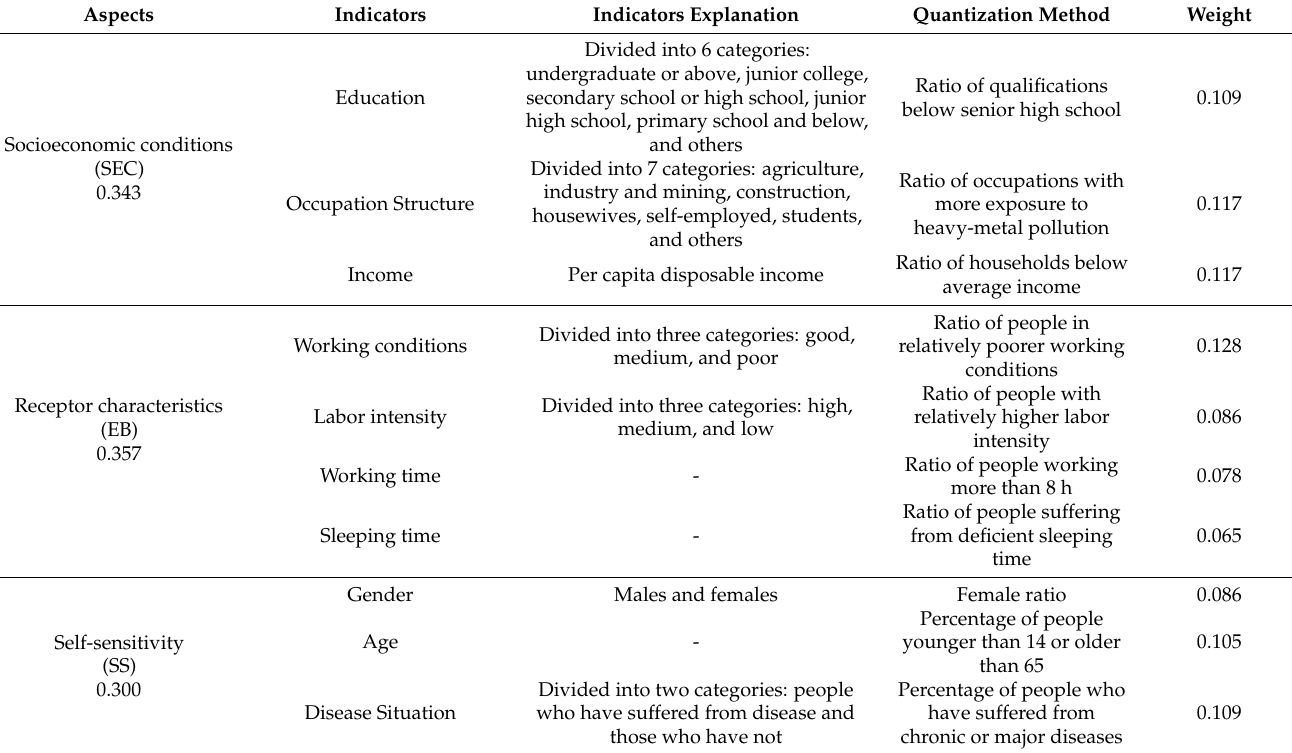
Table 2. Explanation and quantification of social vulnerability indicators.